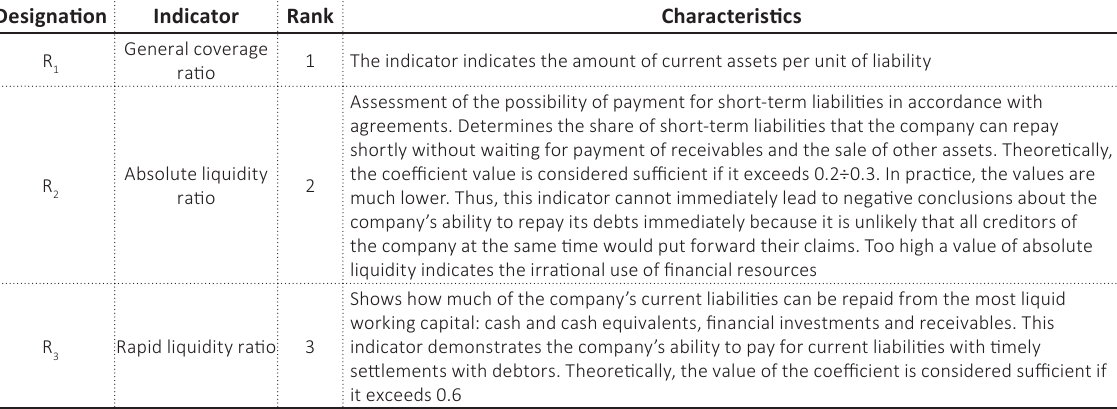
Table 2. Indicators for assessing the stability of production and trading